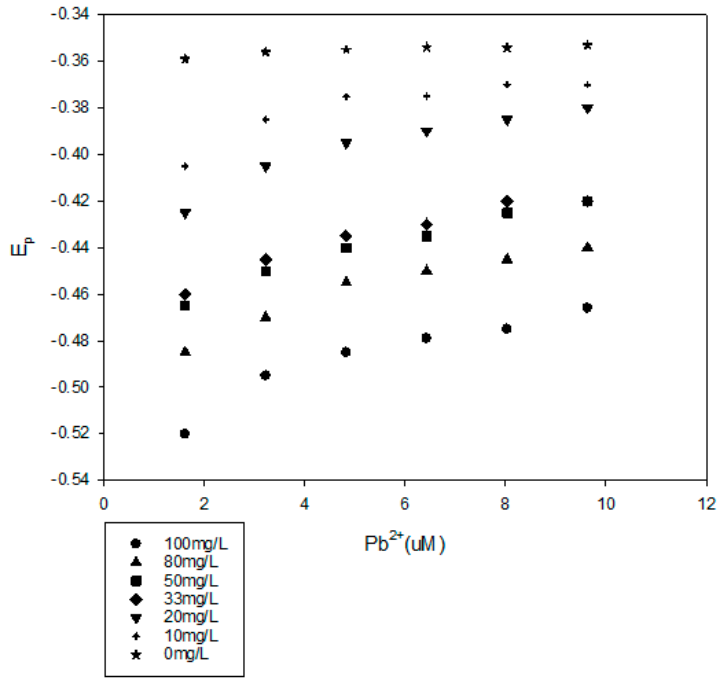
Figure 5. DPP results for Pb 2 + at pH 8 in the presence of varying concentrations of the Pahokee peat humic acid.